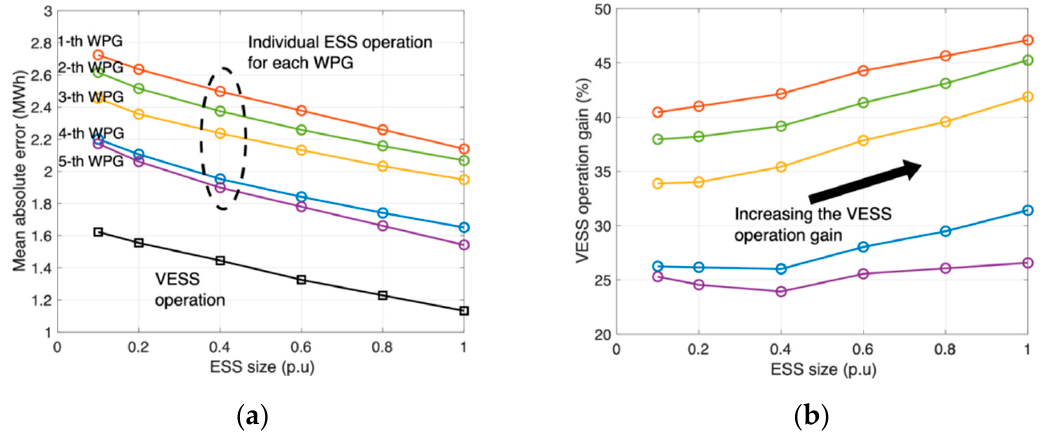
Figure 4. MAE comparison among individual ESS operation and VESS operation. ( a ) Mean absolute error; ( b ) Optimal gap.